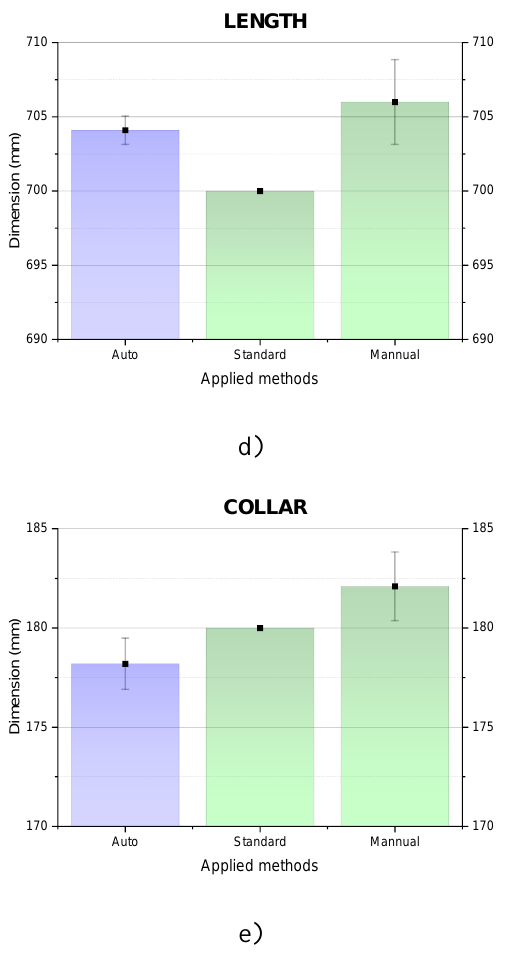
Figure 16. Comparison of the proposed system and manually measured results of: a) Bottom, b) Chest, c) Sleeve, d) Length, and e) Collar